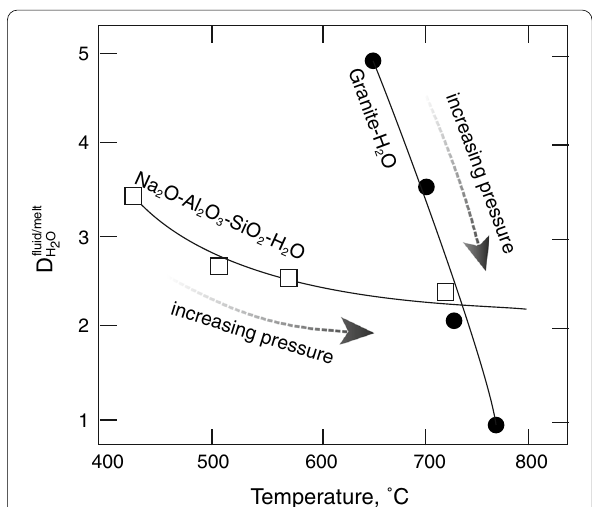
Fig. 2 H 2 O partitioning between fluid and melt in the Na 2 O–Al 2 O 3 – SiO 2 –H 2 O system. Data from Shen and Keppler (1997) and Mysen ( 2013